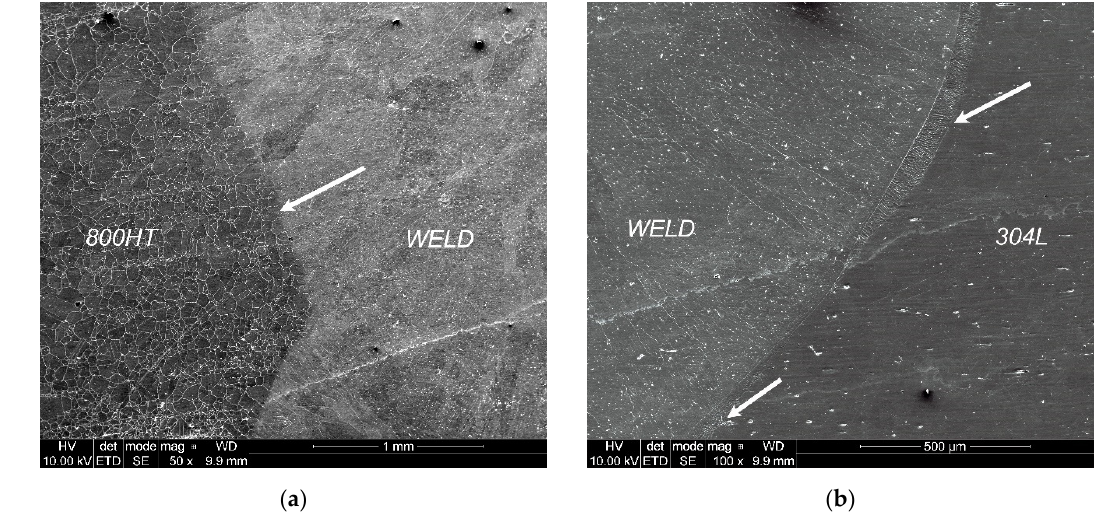
Figure 9. SEM micrograph showing interface between ( a ) weld–fusion line and Incoloy 800HT nickel alloy (type A fusion boundary) and ( b ) weld–fusion line and 304L austenitic stainless steel (type B fusion boundary).